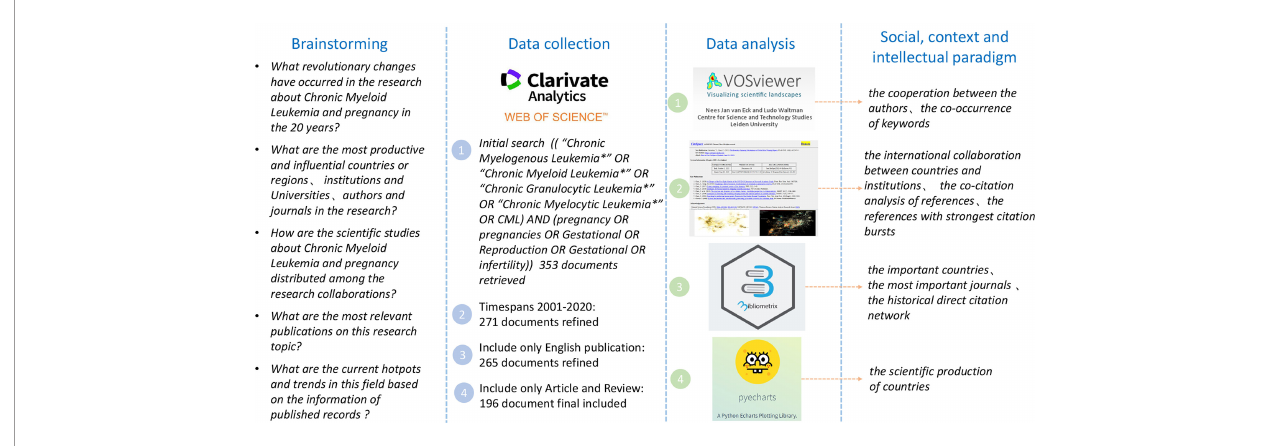
FIGURE 1 | Conceptual design of the study.